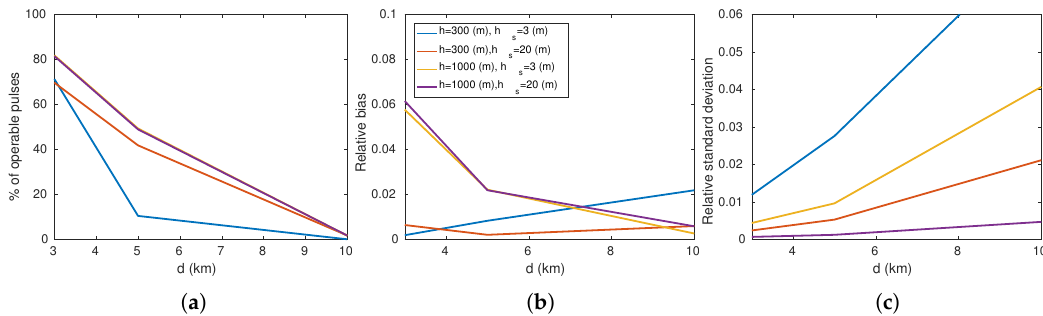
Figure 10. Percentage of operable pulses ( a ), relative bias ( b ) and relative standard deviation ( c ) as a function of the projected radar distance d , the radar height h r , the scatterer height h S ( δ r = 5 m, f c = 0.5 GHz, f s = 1